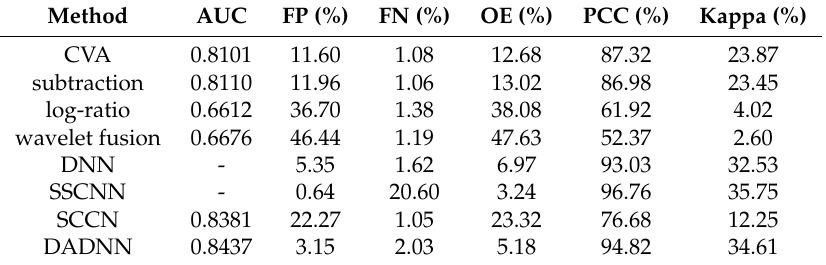
Figure A11. Change detection results obtained by different methods in the Hongkong data set: ( a ) CVA, ( b ) subtraction, ( c ) log-ratio, ( d ) wavelet fusion, ( e ) DNN, ( f ) SSCNN, ( g ) SCCN, ( h ) DADNN, and ( i ) ground truth. Table A2. Value of evaluation criteria of the Hongkong data